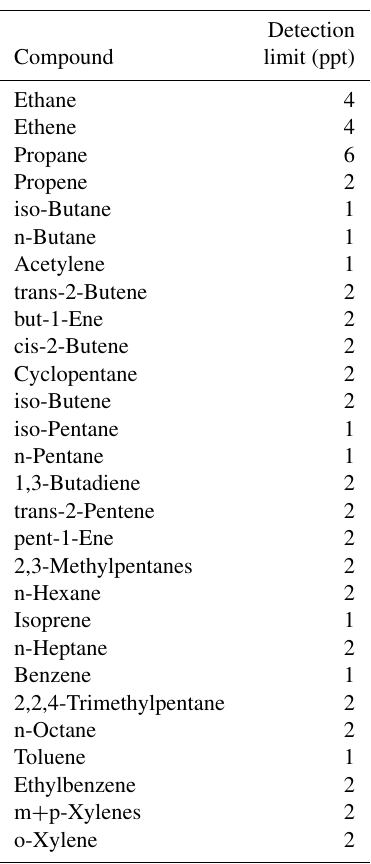
Table A2. Summary of VOCs measured from SWAS samples at the University of